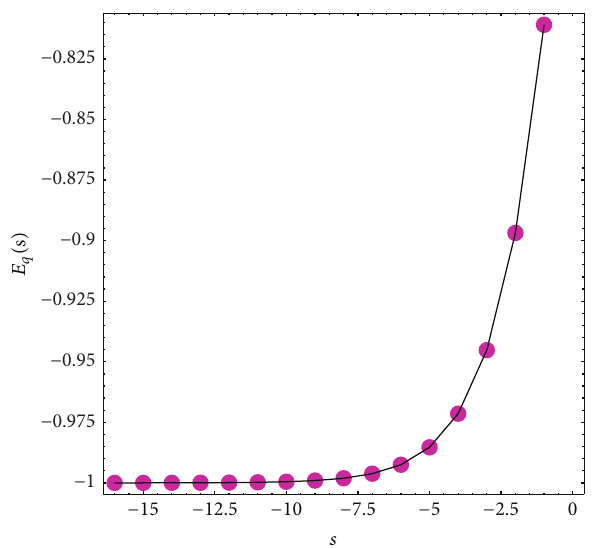
Figure 2: The curve 𝐸 𝑞 (𝑠) runs through the points 𝐸 −𝑛,𝑞 for 𝑞 = 1/2 .